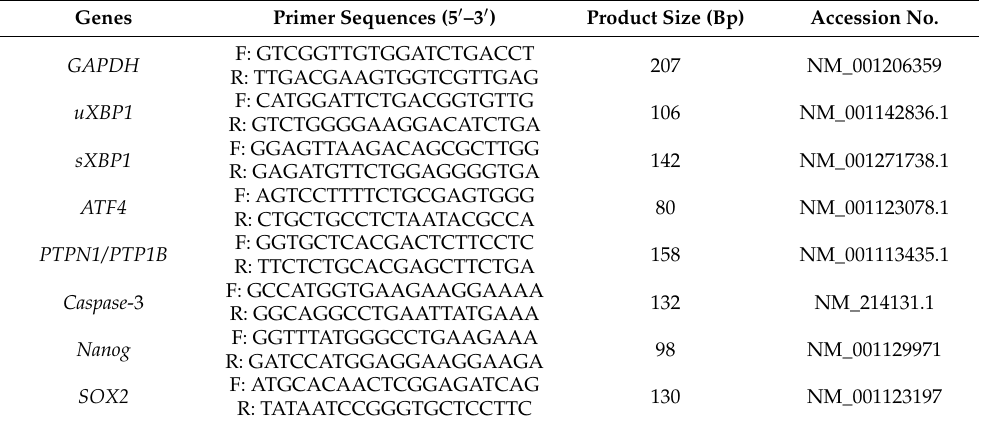
Table 1. Primer sequences for